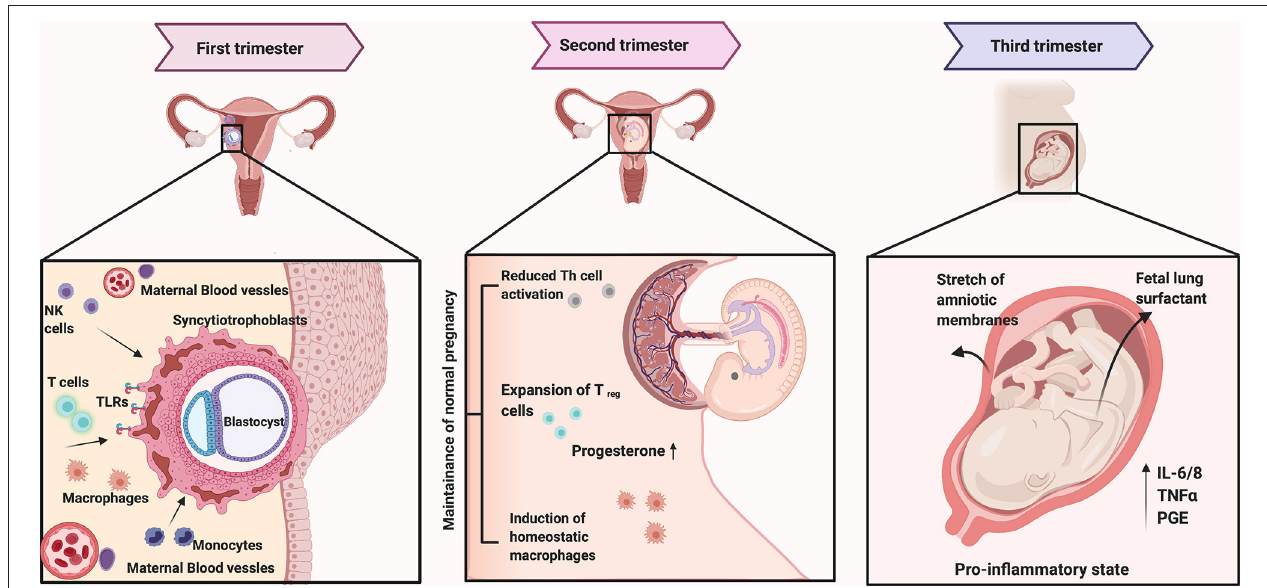
FIGURE 1 | The first trimester in pregnancy is marked by activated inflammation beginning with the adherence of the blastocyst to the uterine wall. The invading trophoblasts from the blastocyst secrete chemokines to recruit maternal innate (monocytes, macrophages, and natural killer cells) and adaptive immune cells [including a restricted subset of CD4 + and CD8 + T cells and regulatory T cells (T reg )]. Simultaneously, there is the proliferation of resident tissue leukocytes, particularly decidual natural killer (dNK) cells and decidual dendritic cells (dDCs). Trophoblasts impart an immature phenotype to local dDCs that encourages differentiation of T regs and a tolerogenic Th2-polarized environment with high levels of classically anti-inflammatory cytokines, such as IL-10. The second trimester or mid pregnancy is marked with immune senescence with increased progesterone and T reg dominant response. As the pregnancy approaches term, the local indicators of fetal maturity trigger the maternal immune system to undergo a shift toward a pro-inflammatory state again with its peak at term. Further, the stretch of amniotic membranes as well as the fetal lung surfactant have been shown to activate inflammatory responses to facilitate parturition. Figure created using the BioRender